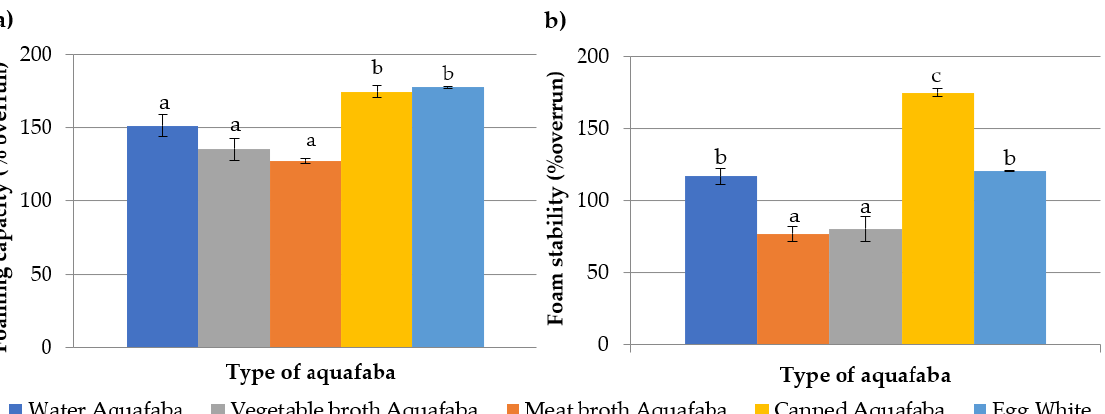
Figure 1. Foaming capacity ( a ) and foam stability ( b ) expressed in % of overrun of Pedrosillano chickpea aquafaba obtained with different broths and egg white. a – c Means with different superscripts showed significant differences ( p < 0.05).